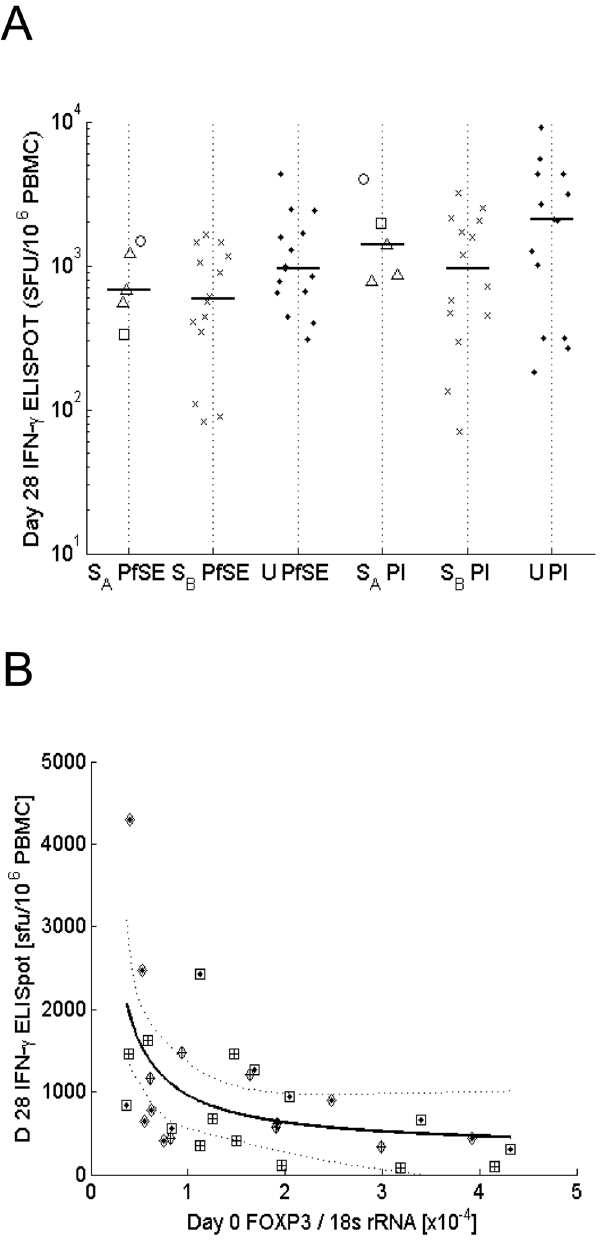
Figure 7. Tregs induced during the clinical episode under study limit the magnitude of subsequent malaria-specific IFN- c memory responses. (A) PBMCs collected on day 28 were cultured for 6 days with PfSE, uRBC, P + I or GM, respectively, and assayed in an IFN- c ELISpot to measure the magnitude of the malaria specific memory response. Background levels of IFN- c production obtained in uRBC or GM were deducted from PfSE or PI. (B) cultured IFN- c ELISpot responses to PfSE (D 28) are plotted against FOXP3 mRNA levels measured on day 0. A linear by linear hyperbolic fit revealed a significant association (p=0.009). + : severe cases; # : uncomplicated cases. Scattered lines indicate the 95% CI limits. At the 5% level there is no significant improvement in fit, using separate lines for severe and uncomplicated patients. No significant effect of parasitaemia could be observed. Depending on a parasitaemia level above or below the median parasitaemia in both groups, a diamond (high) or a square (low) was added to individual data points to illustrate